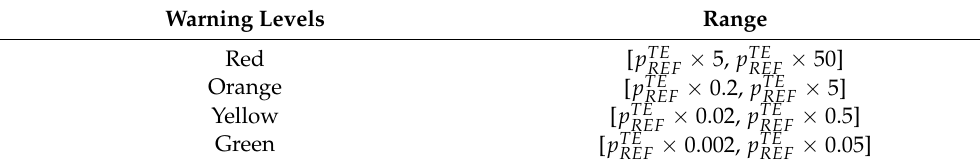
Table 1. Warning